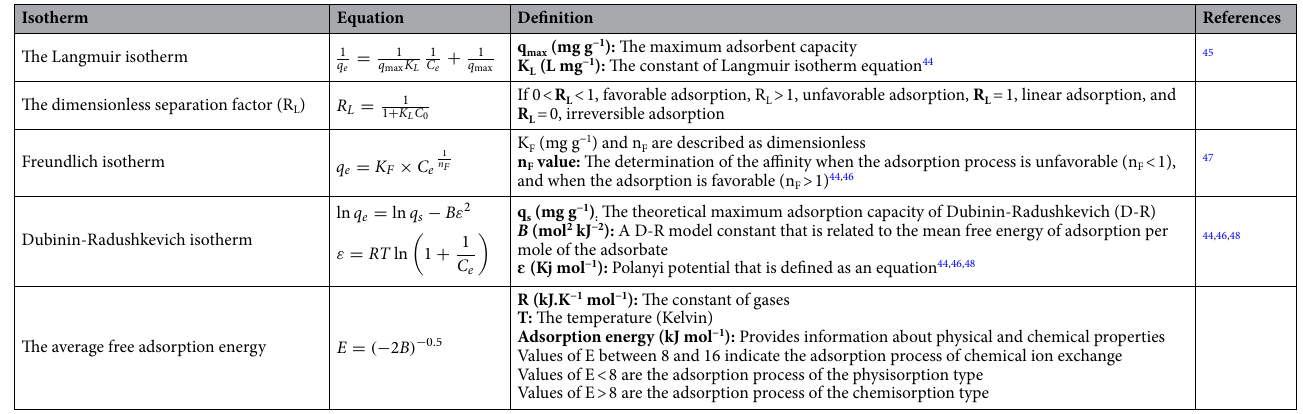
Table 1. The Langmuir, Freundlich, and Dubinin-Radushkevich isotherm equations.